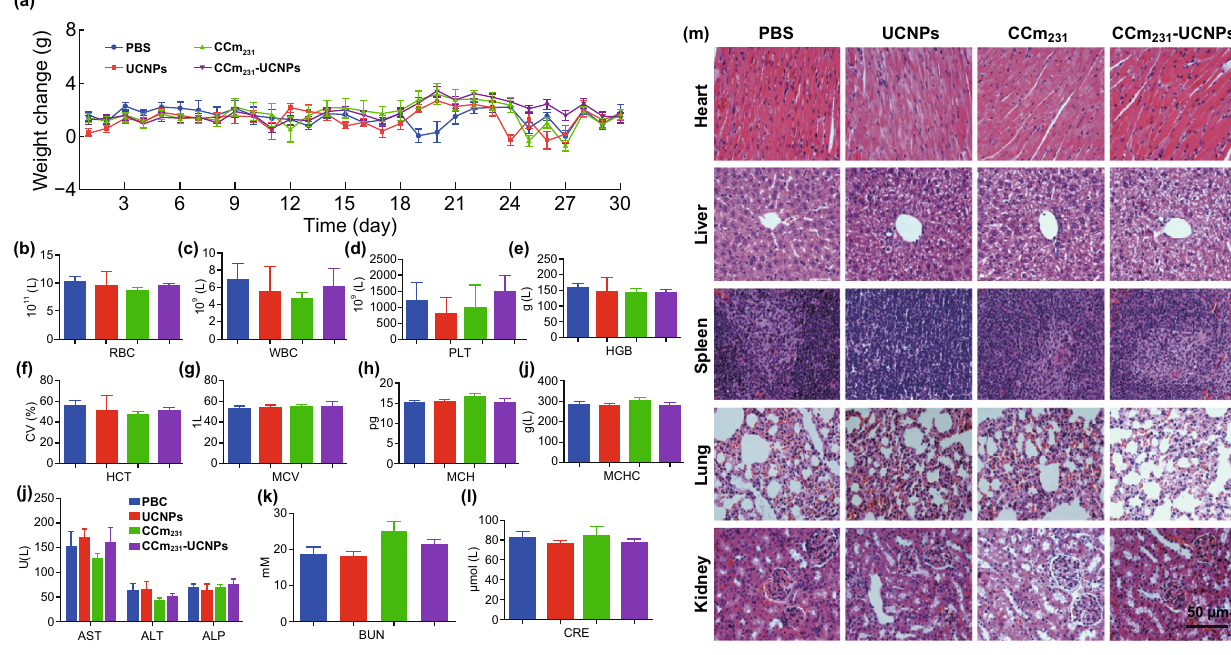
Fig. 5 In vivo toxicity evaluation. a Mice body‑weight‑change curves over 30 days after i.v. injection with PBS or PBS containing UCNPs, CCm 231 , and CCm 231 ‑UCNPs. b – i Blood parameter data. Red blood cells (RBCs), white blood cells (WBCs), platelets (PLT), hemoglobin (HGB), hematocrit (HCT), mean corpuscular volume (MCV), mean corpuscular hemoglobin (MCH), and mean corpuscular hemoglobin con‑ centration (MCHC). j – l Blood biochemistry data. Alkaline phosphatase (ALP), aspartate aminotransferase (AST), alanine transaminase (ALT), creatinine (CRE), and blood urea nitrogen (BUN). m H&E‑stained slice images of major organs. The scale bars = 50 μm. The data points repre‑ sent the mean ± SD ( n =